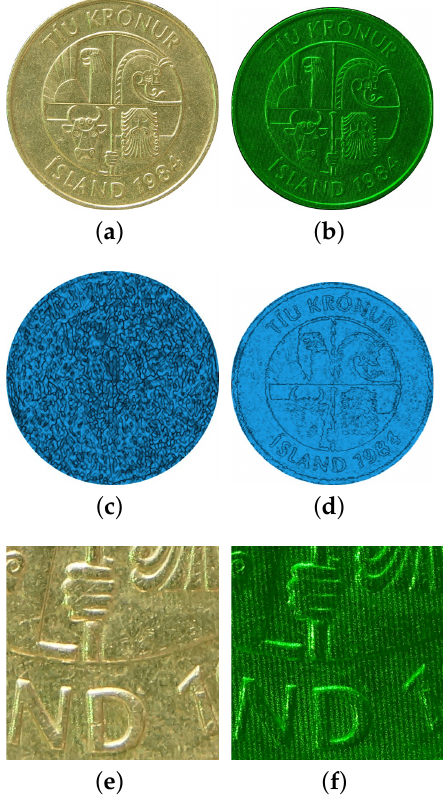
Figure 7. Illuminated coin and its retrieval as background illuminance E = 35,000 Lux for outdoor measurement. ( a ) without filtering; ( b ) with filtering; ( c ) retrieval using the image of ( a ); ( d ) retrieval using the image of ( b ); ( e ) part of the enlarged image of ( a ); ( f ) part of the enlarged image of ( b ). When the background illuminance changes from E = 1000 Lux to E = 35,000 Lux